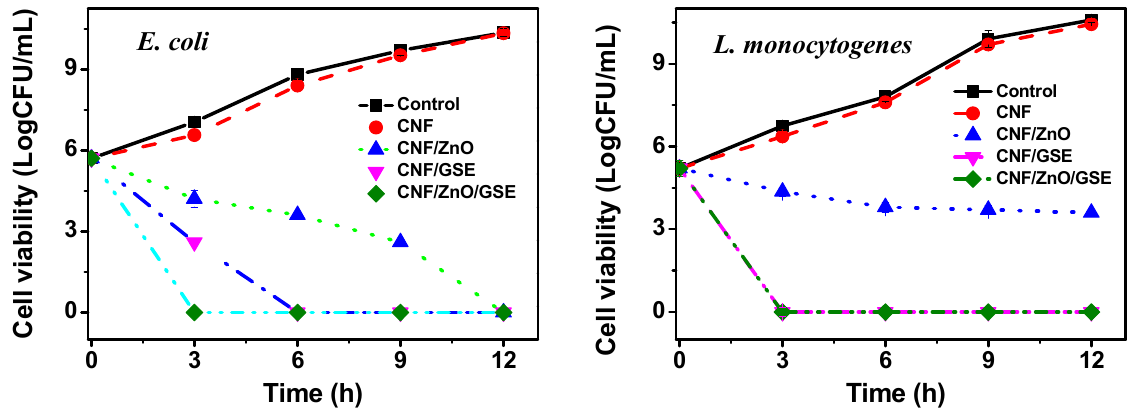
Figure 8. Antimicrobial activity of CNF/ZnO/GSE films.